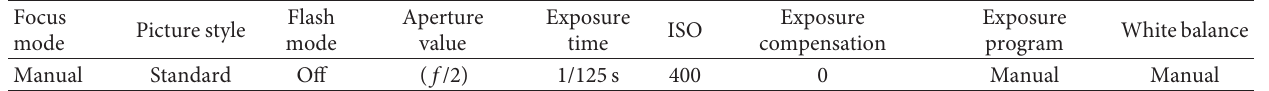
Table 3: Camera settings of the surface color contrast